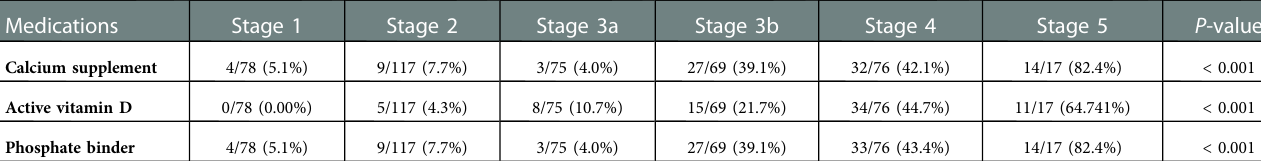
TABLE 3 Medications for CKD-MBD in the KNOW-Ped CKD cohort according to CKD stages. Medications